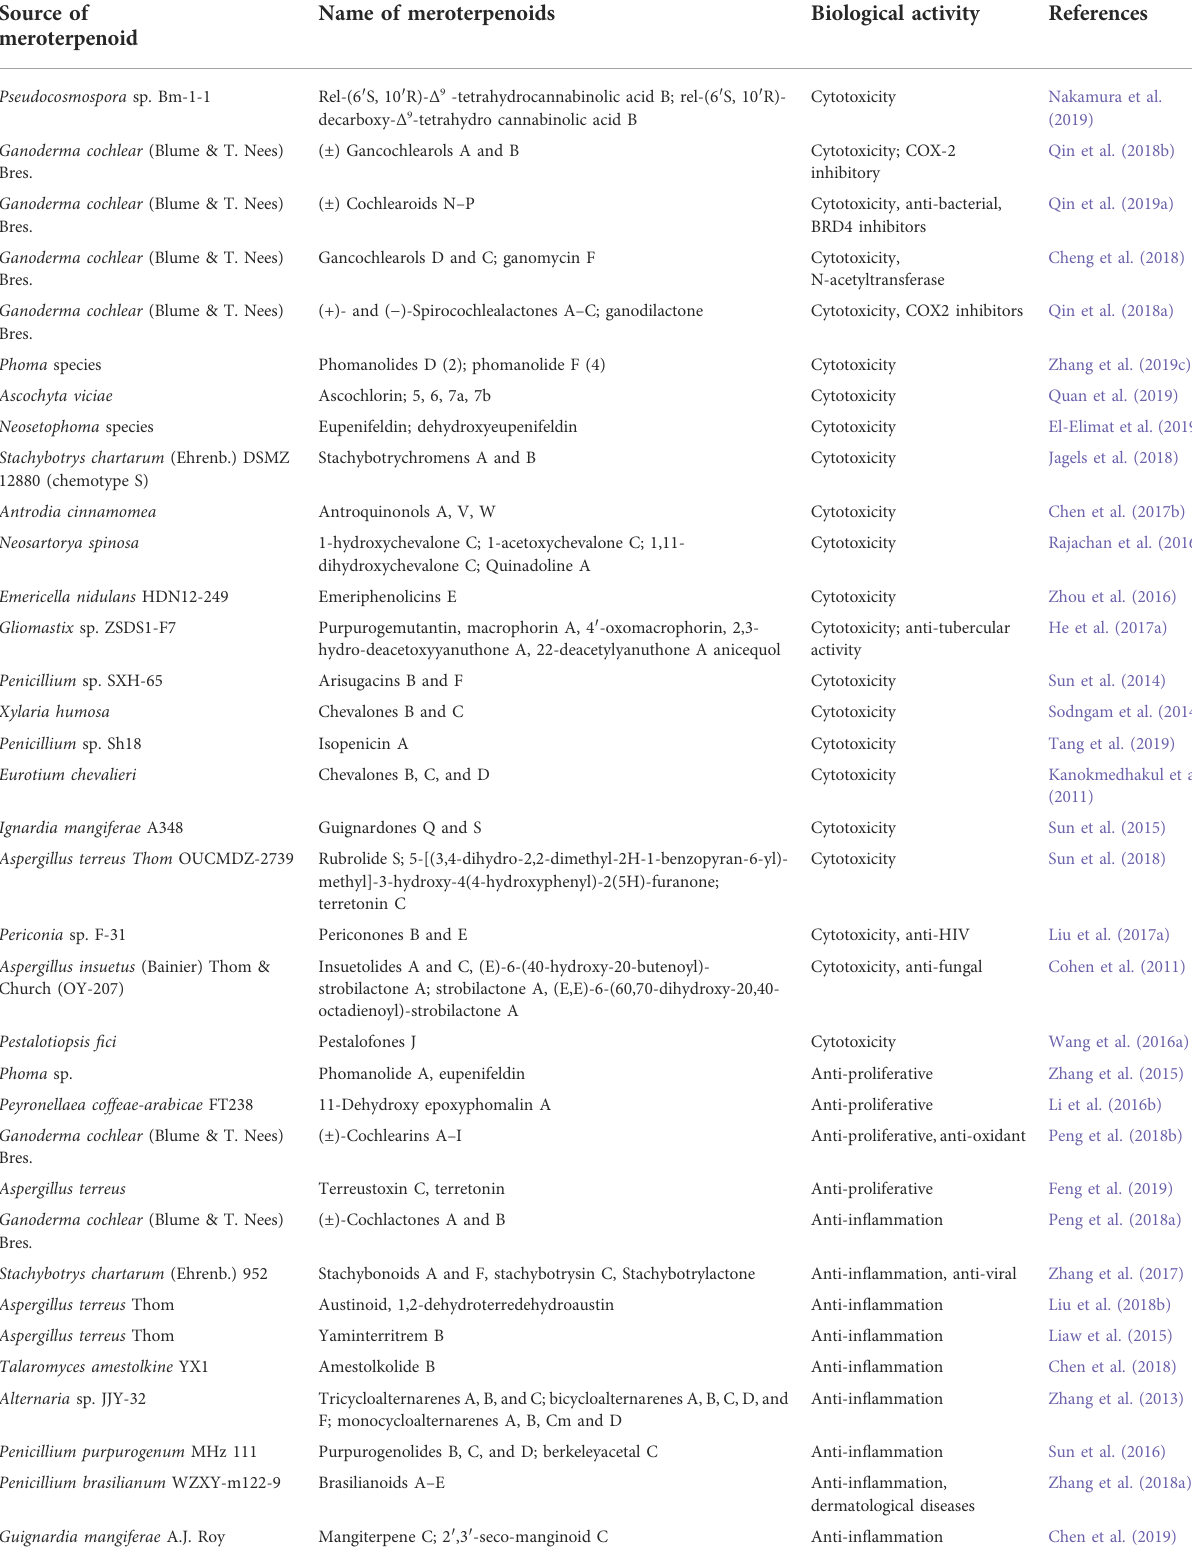
TABLE 1 Sources and biological activity of fungus